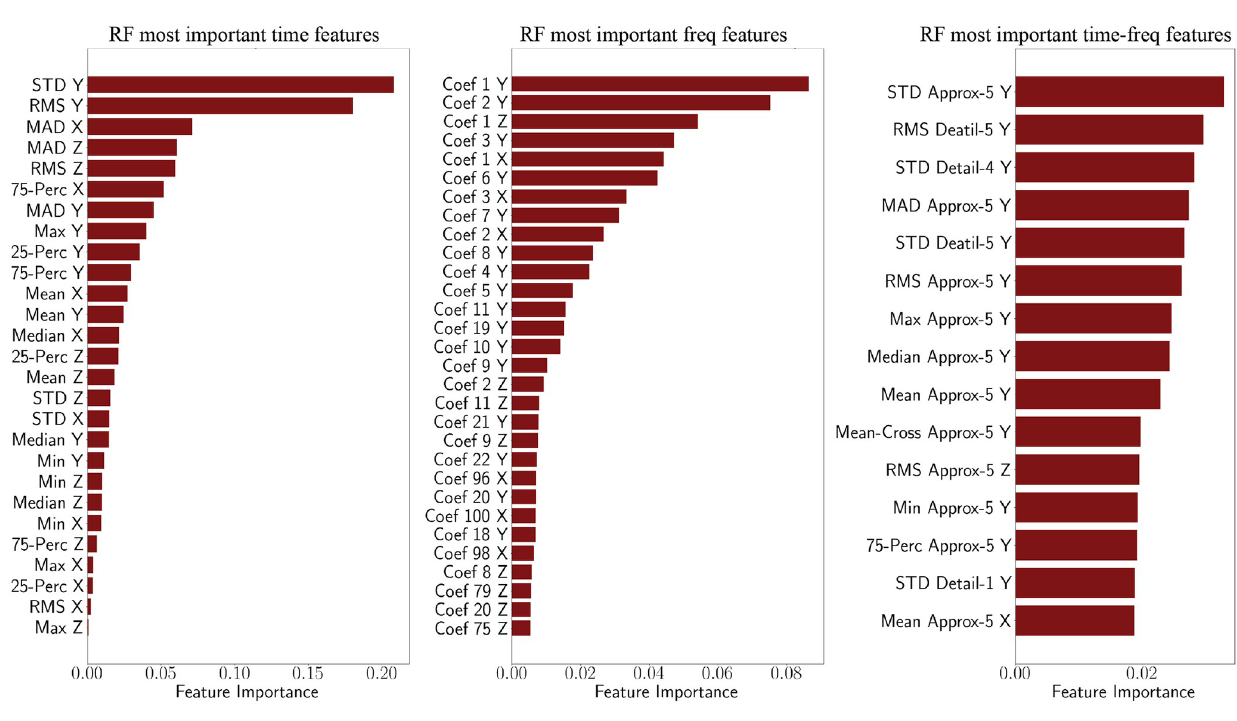
Fig 6. Overall feature importance from